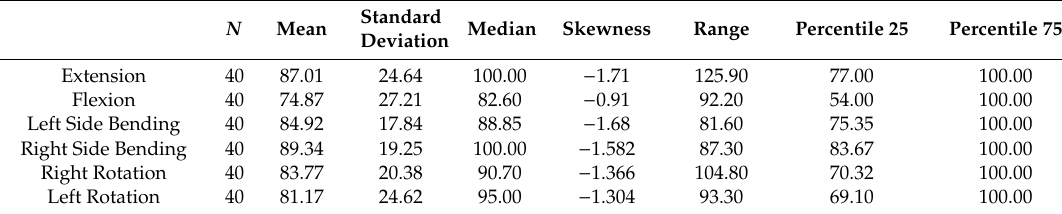
Table 8. Case group normalized values of ROM using our own